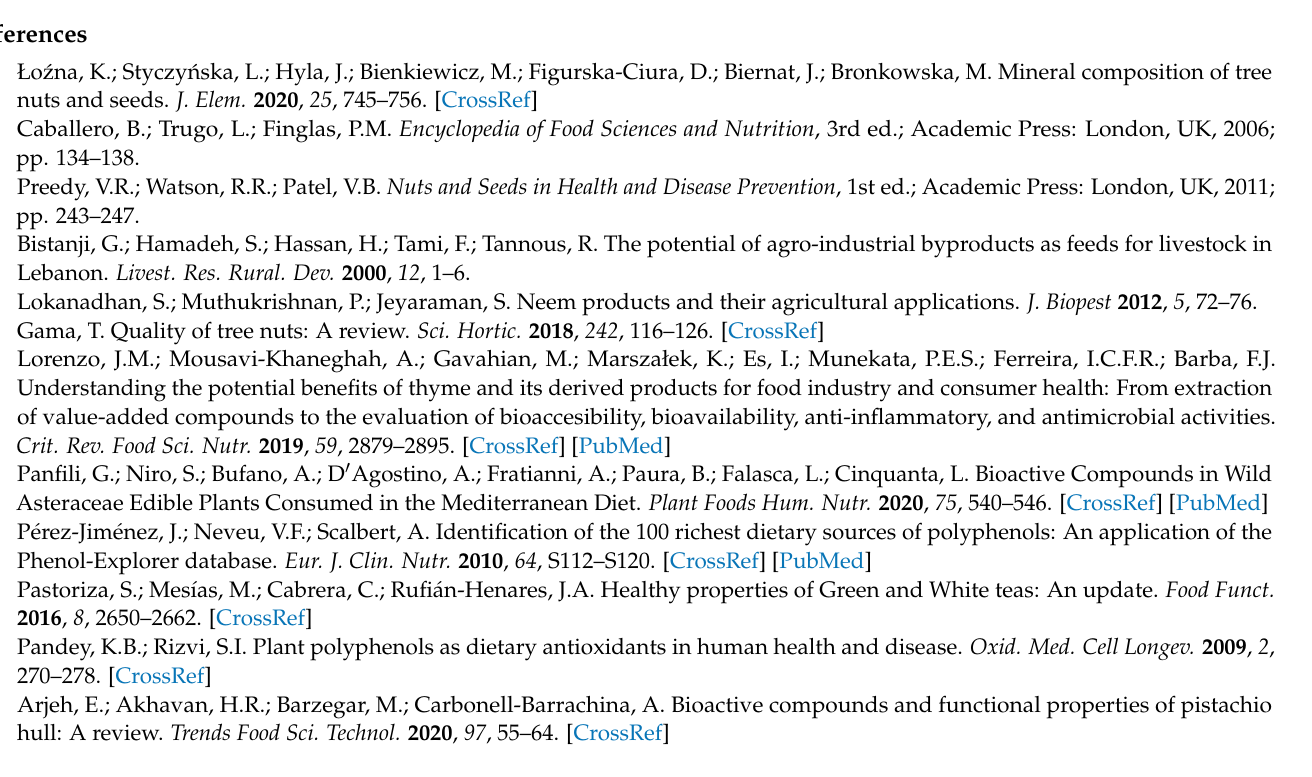
seeds; Table S1: Mineral element concentration of seeds (mg/100 g); Table S2: Mineral element concentration in cultivars familywise (mg/100